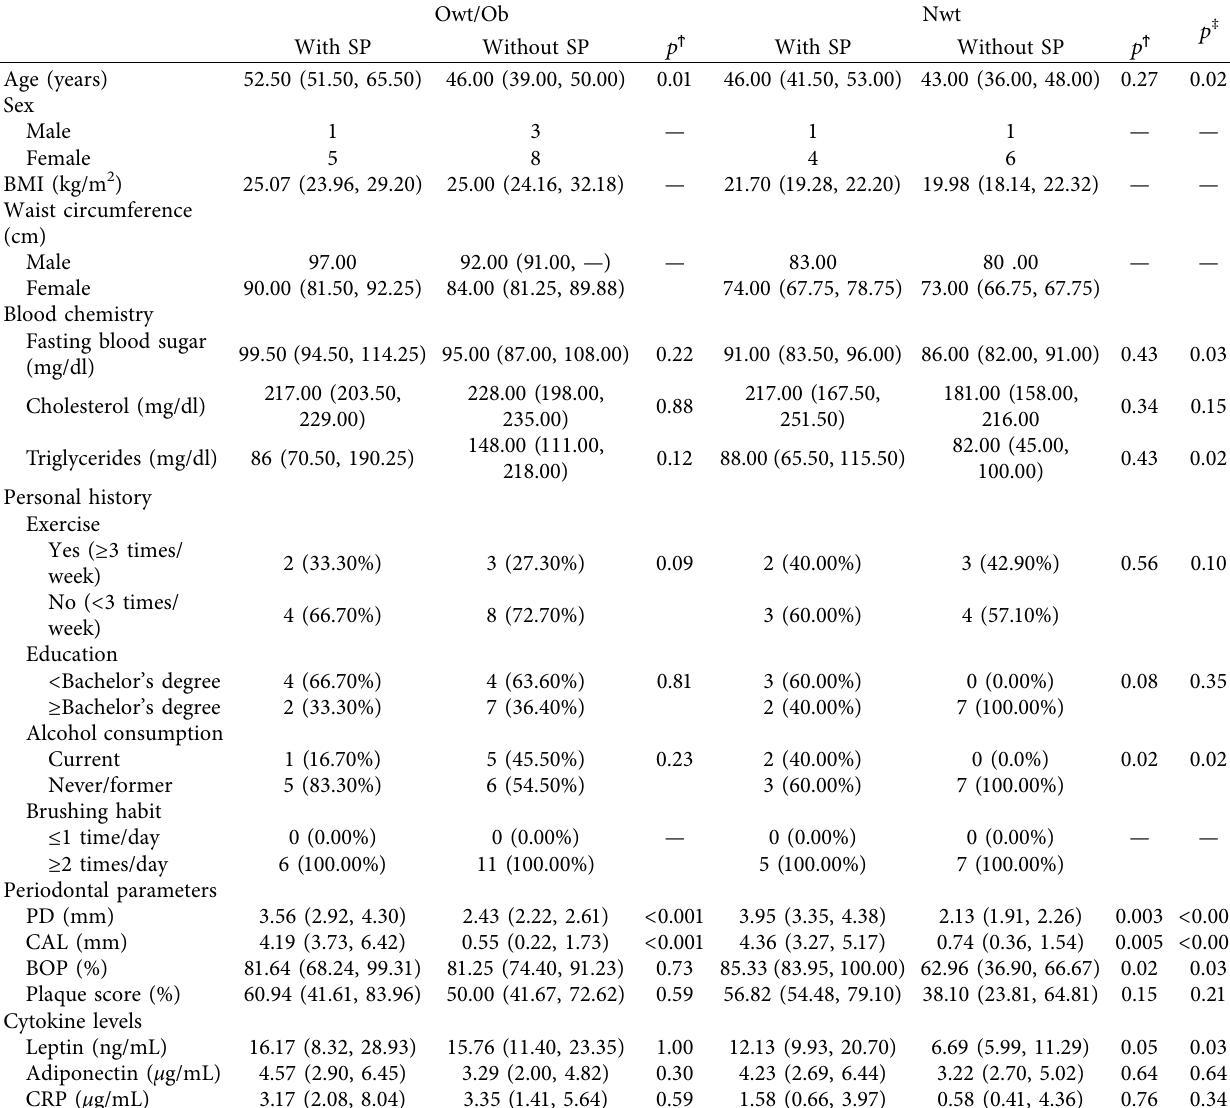
Table 1: Characteristics of participants, according to BMI and periodontal disease status at